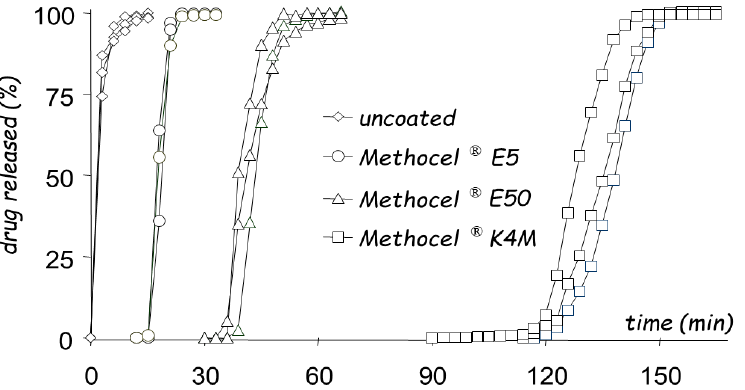
Figure 18. SEM photomicrographs of cross-sectioned systems spray-coated with Methocel ® E5, E50 and K4M, respectively, to 20% weight gain. Adapted with permission from Ref. [60]. 2004, Elsevier.